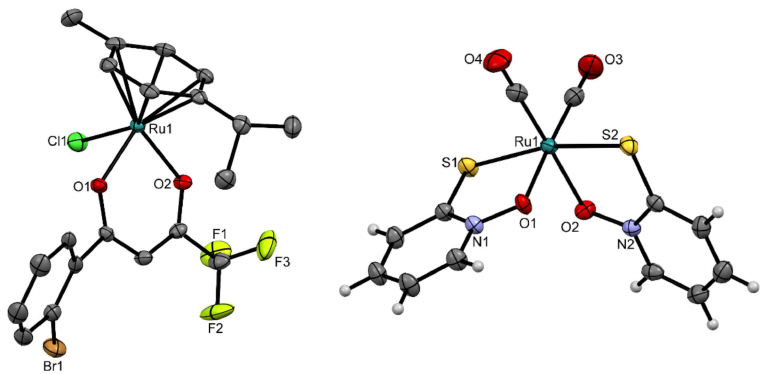
Figure 3. Crystal structures of complexes 4 ( left ) and 8 ( right ). Displacement ellipsoids are drawn at the 50% probability rate. Hydrogen atoms are omitted for clarity ( left ) or shown as spheres of arbitrary radii ( right